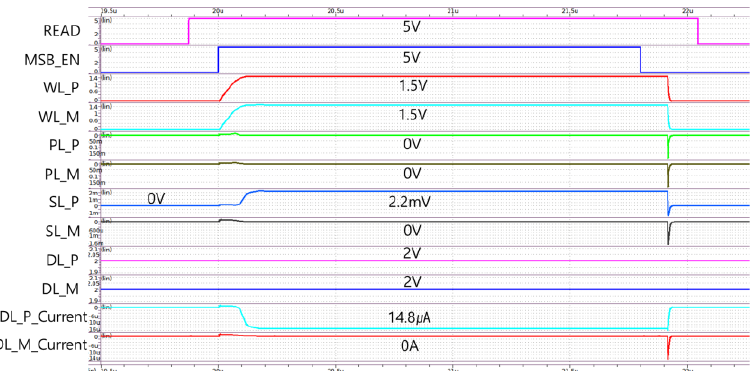
Figure 18. Post-layout simulation result of read operation when the shift register of 324 rows is loaded with hexadecimal FF.